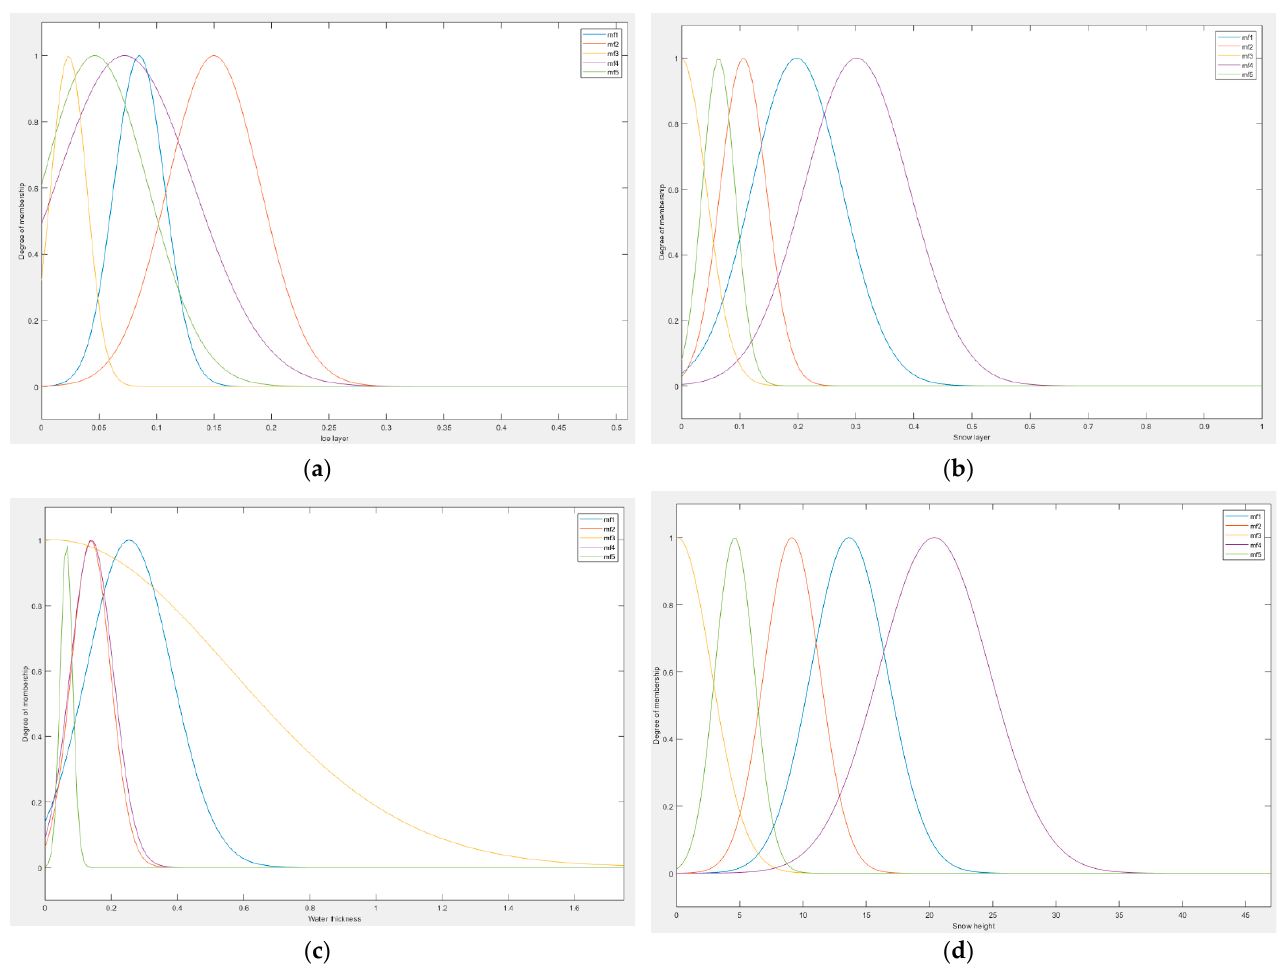
Figure 3. The fuzzy membership functions (Gaussian) selected for ( a ) ice layer, ( b ) snow layer, ( c ) water thickness, and ( d ) snow height. Table 5. Information about selected inputs and output.